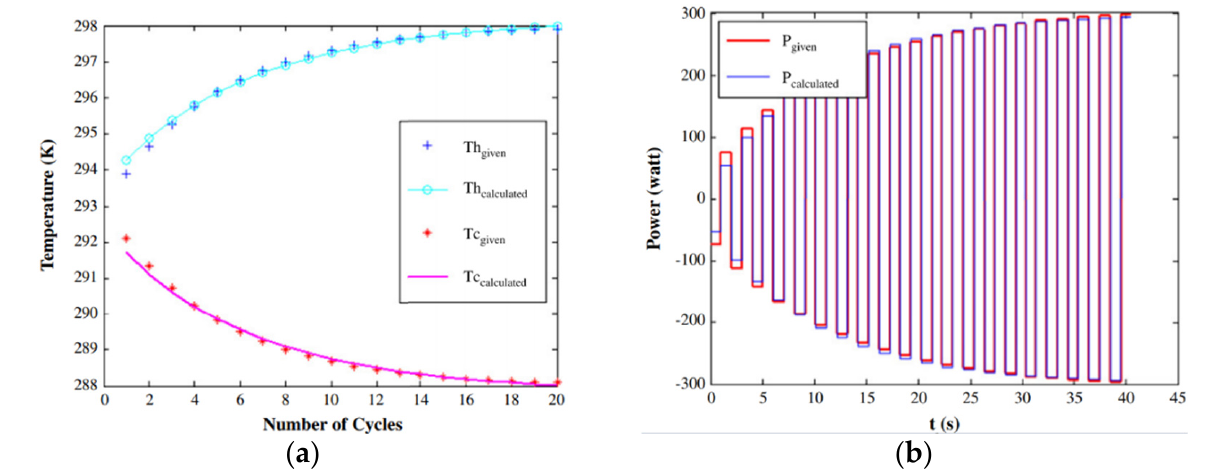
Figure 15. Comparison between the input parameters and the calculated parameters for the: ( a ) temperature evolution; ( b ) power evolution [56].